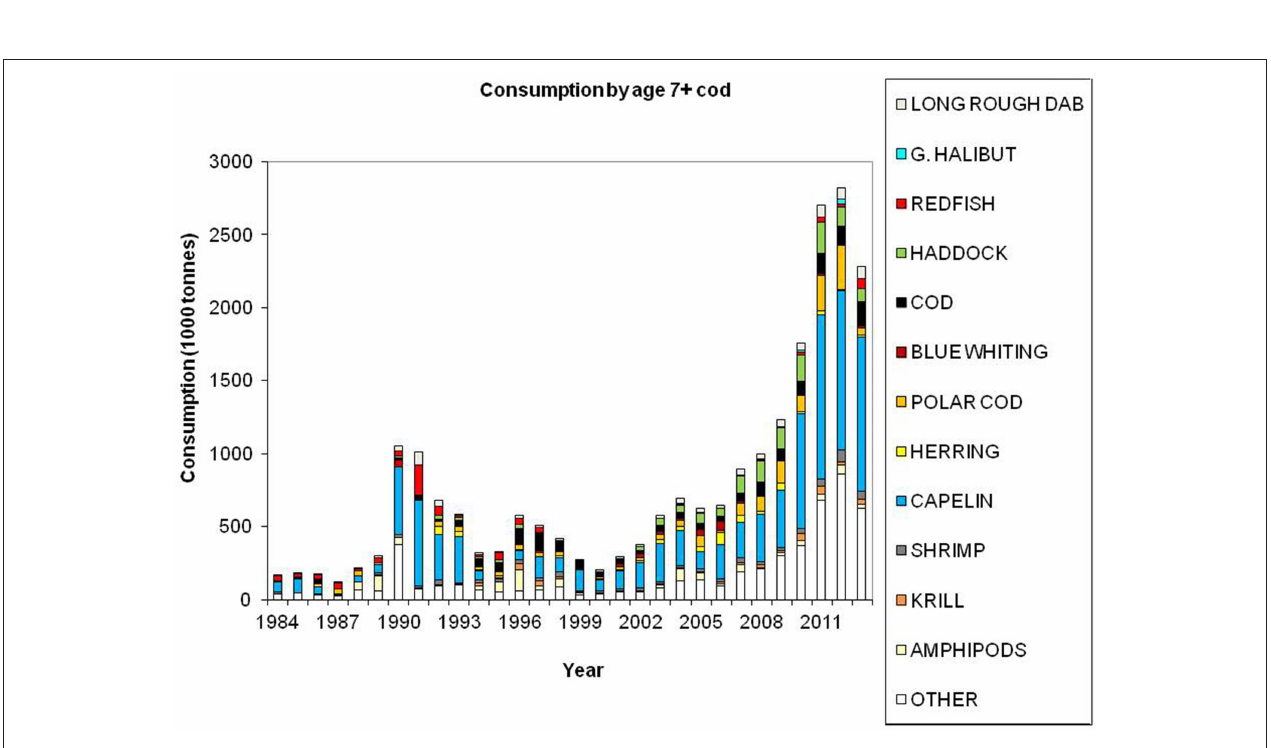
FIGURE 9 | Total consumption by age 7 + cod based on calculations presented in ICES (2014a), using the method described by Bogstad and Mehl (1997). These calculations are